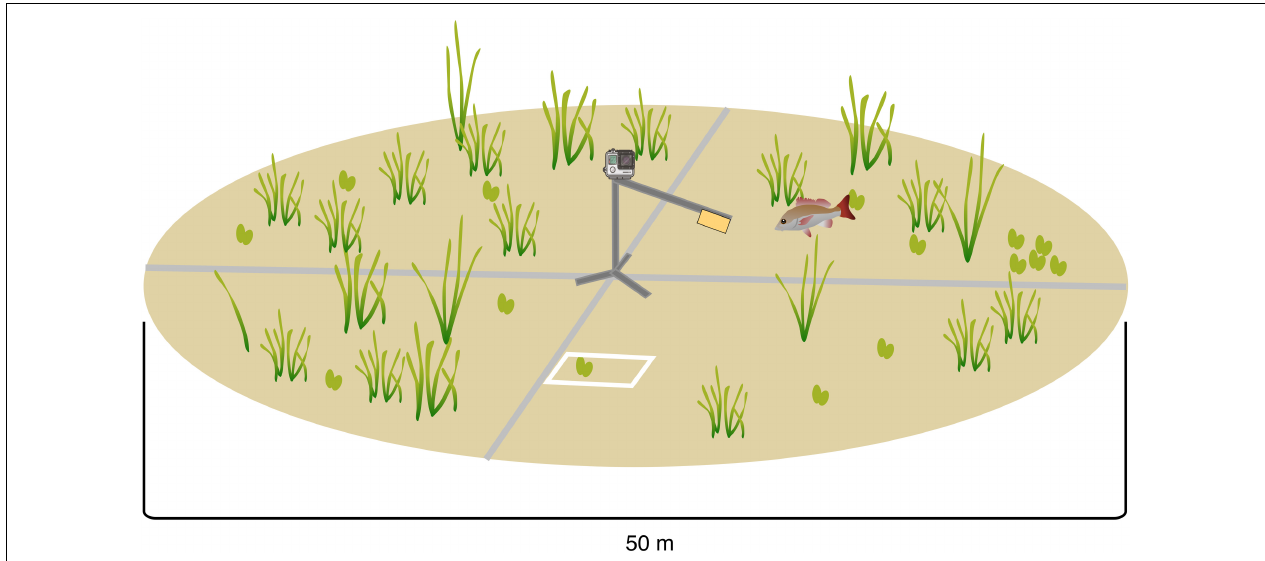
FIGURE 2 | Conceptual diagram of survey setup at each sample location, showing the location of the Baited Remote Underwater Video (BRUV) system toward the center of the sample plot and location of the two 50m transects (not to scale).